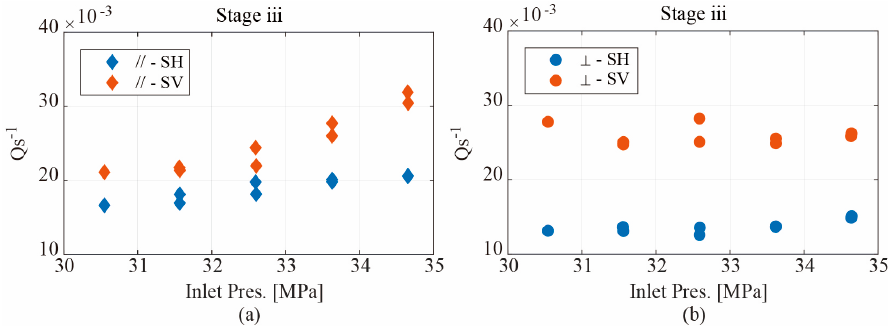
Figure 13. Comparison of measured (cid:1843) //(cid:2879)(cid:3020)(cid:2879)(cid:2869) ( a ) and (cid:1843) (cid:2884)(cid:2879)(cid:3020)(cid:2879)(cid:2869) ( b ) in stage iii, respectively.